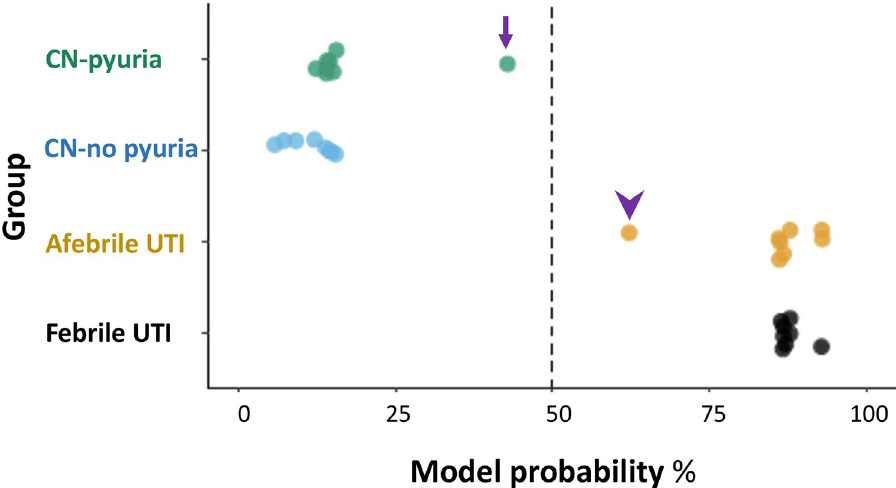
Fig 4. The UTI class probability estimate for each sample by the optimal SVM classifier. The dashed black line shows where the 50% probability lies. Generally, model probability of predicting UTI samples was > 80%. There are 2 outliers, one 18-year old female with CN pyuria (purple arrow) who presented with left flank pain, fever and dysuria along with 1+ LE on UA and had 43.4% UTI probability. The other outlier (purple arrowhead) was a 3-year-old female who presented with fever and abdominal pain, along with 1+ LE and had 62.7% UTI probability.